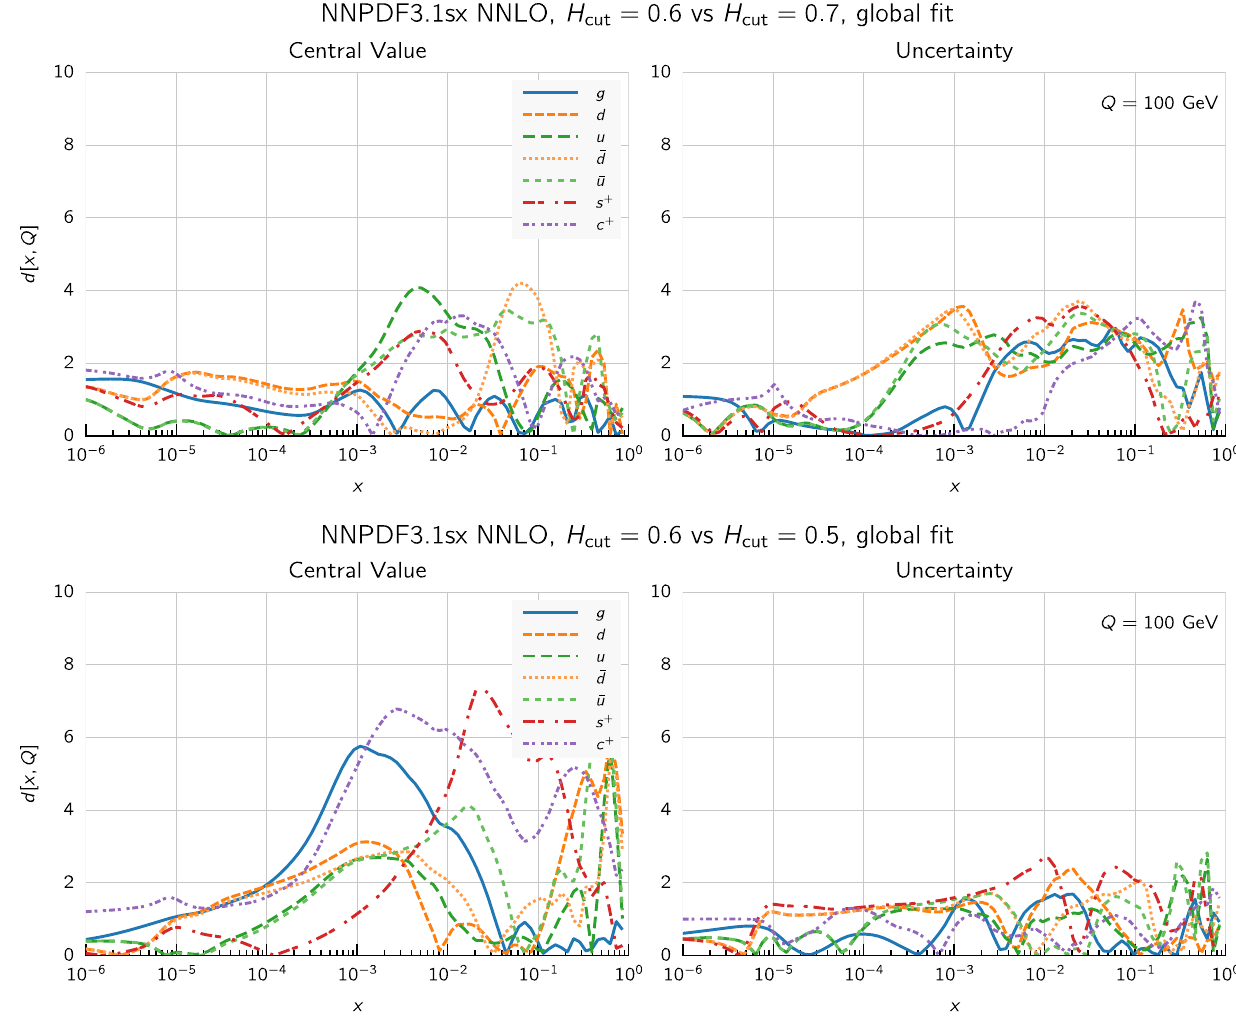
Fig. 17 Same as Fig. 10 for the comparison of the baseline NNPDF3.1sx NNLO+NLL global fit with H cut = 0 . 6 with the corresponding fits with H cut = 0 . 7 (upper) and H cut = 0 . 5 (lower